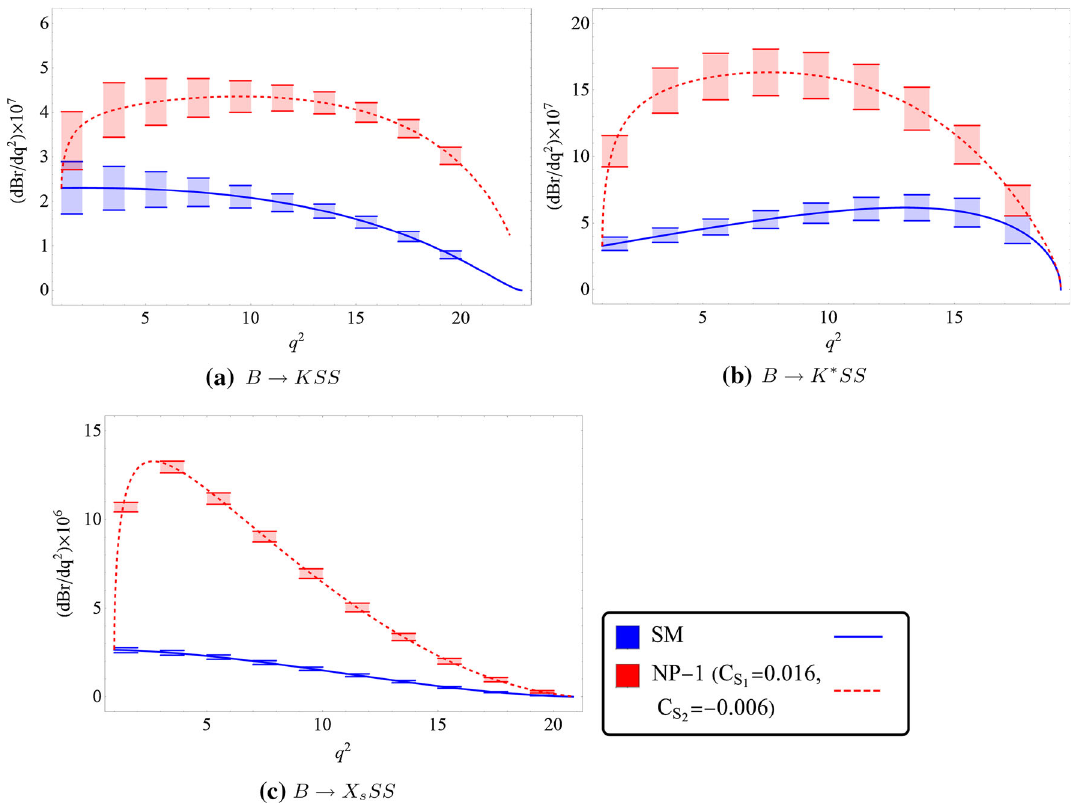
Fig. 6 Comparison of the q 2 (in GeV 2 ) distributions of the decay rates for several b → sSS channels, with L int = 50ab − 1 and m S = 0 . 5